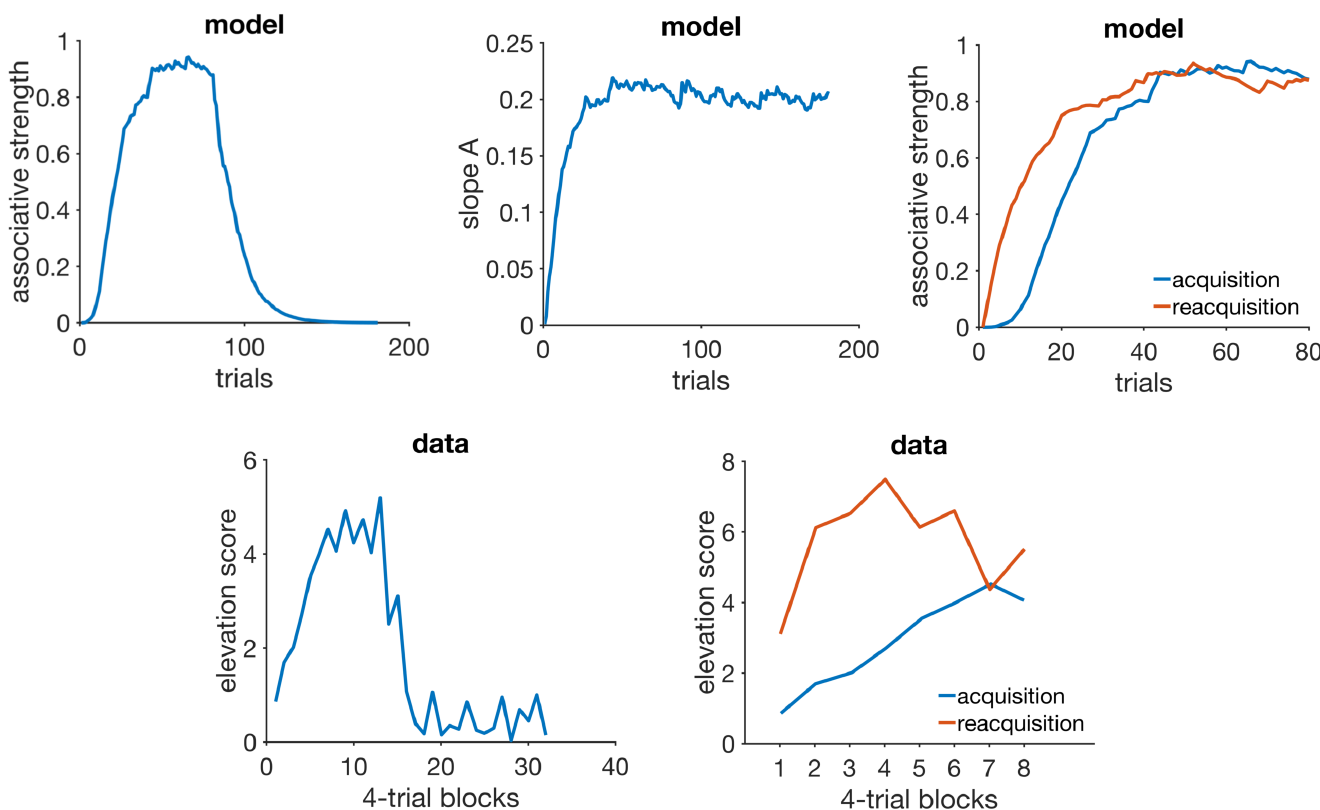
Fig 3. Acquisition and reacquisition. Top left: simulatedassociative strength V in acquisitionand extinction. Top middle: adaptation of RWDDM slope A. CR extinctionbegan at trial 80 but has no effect on the RWDDM slope. Top right panel: simulated V curves in acquisitionand reacquisition.Bottom left panel: responsestrength data from an experiment in acquisitionand extinction, redrawnfrom Fig 1 in [77]. Bottom right panel:data from an experiment in acquisitionand reacquisition, redrawn from the top panel of Fig 3 in [77]. Model parameters: m = 0.15, θ = 1, σ = 0.3, α t = 0.1, α V = 0.1, H = 4 in acquisition and H = 0 in